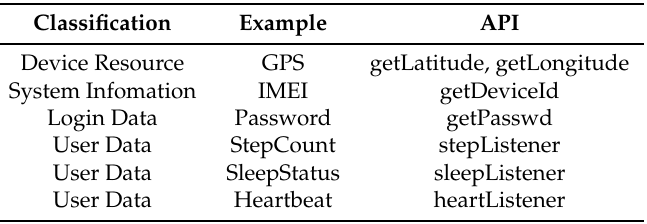
Table 1. Some sensitive privacy-related API functions.